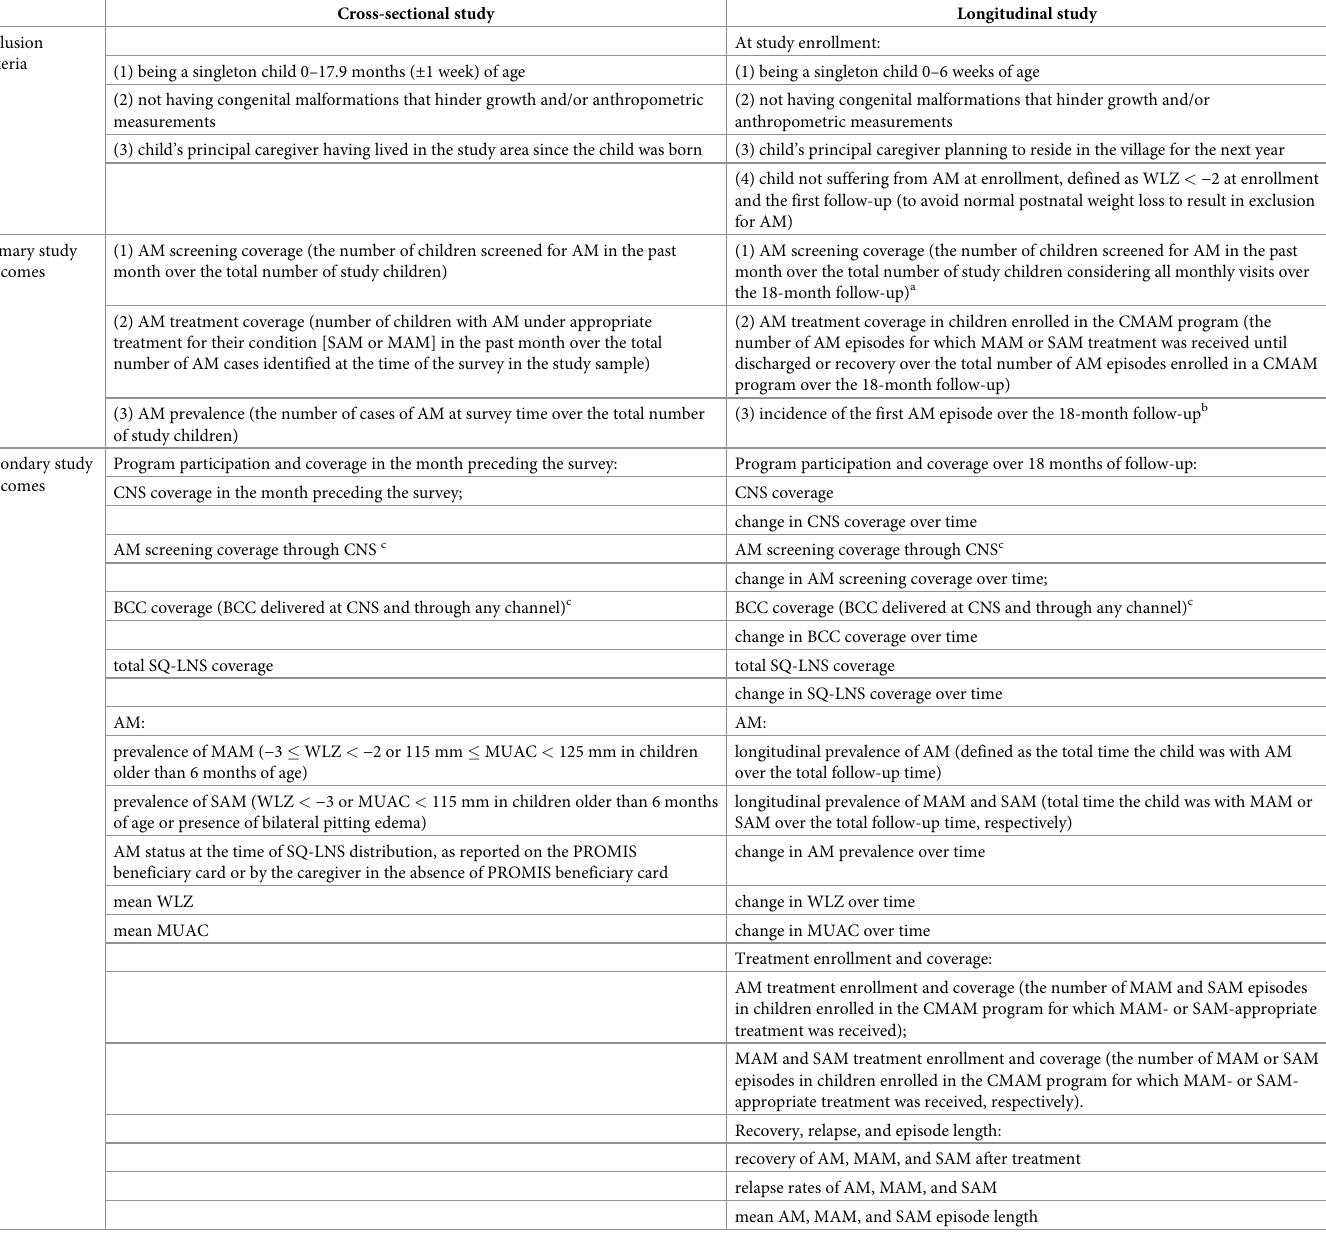
Table 1. Inclusion criteria and primary and secondary study outcomes for the cross-sectional and longitudinal